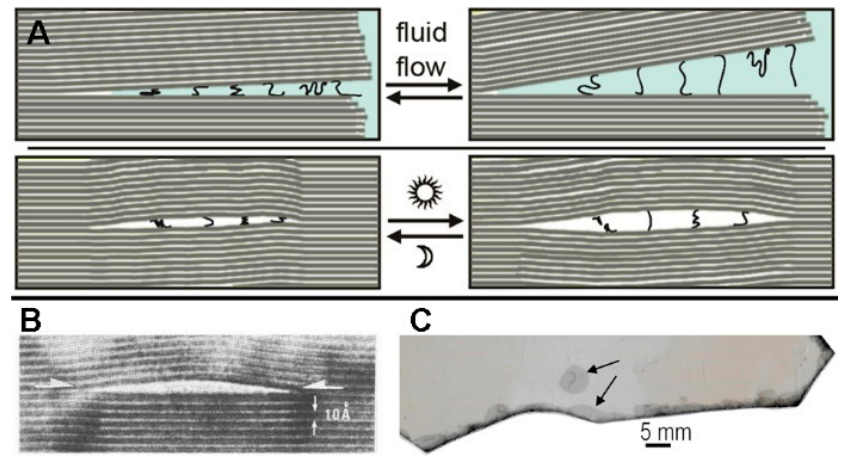
Figure 2. ( A ) Diagram of mechanical forces between biotite mica sheets, stretching and compressing polymers, due to: (Upper panels) water flow at the edges of the biotite sheets, and (Lower panels) heat pumps in a biotite bubble. ( B ) Biotite bubble imaged by HRTEM (high-resolution transmission electron microscopy). The thickness of a single biotite sheet is 1 nm (10 Angstroms) [55]. ( C ) Top view of a bubble in Muscovite mica (upper arrow) and of sheet separation at the edges of the mica sheet (bottom arrow). Bubbles are common even in ‘high grade’ micas. Biotite is now the preferred mica, for life’s origins between mica sheets [56,57].